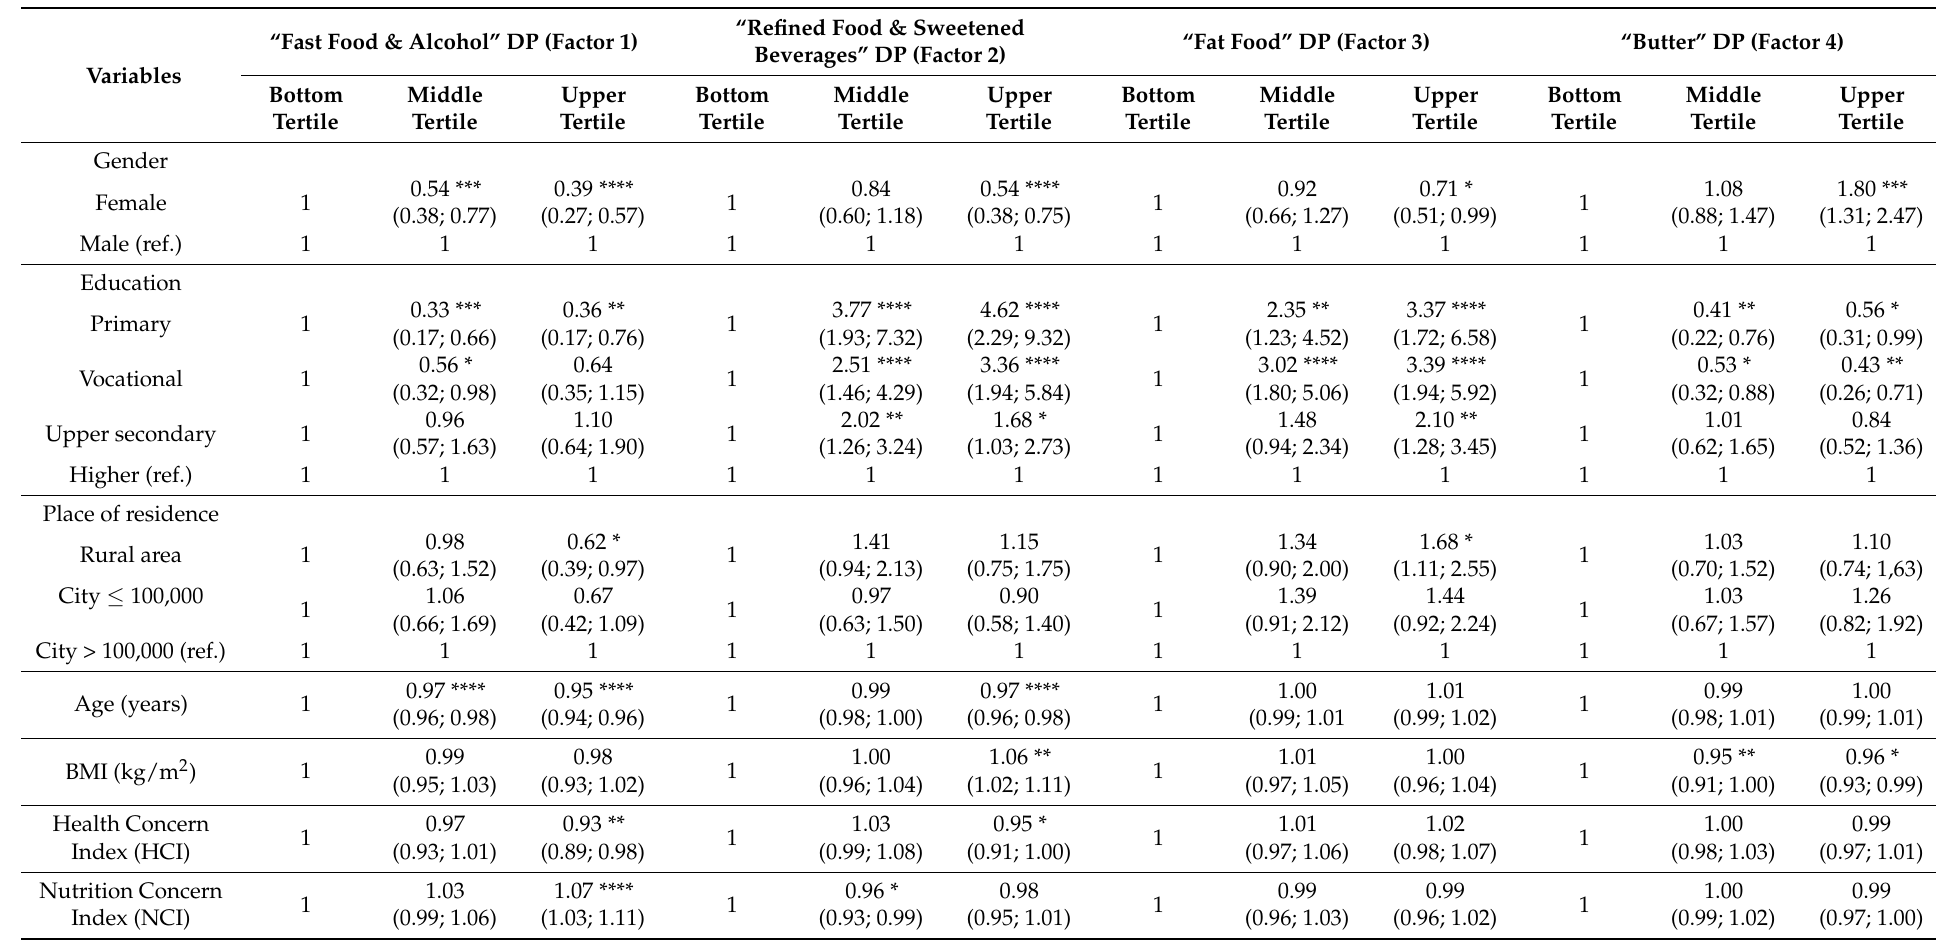
Table 6. Associations between dietary patterns and selected characteristics of the study sample (Odds Ratios with 95% Confidence